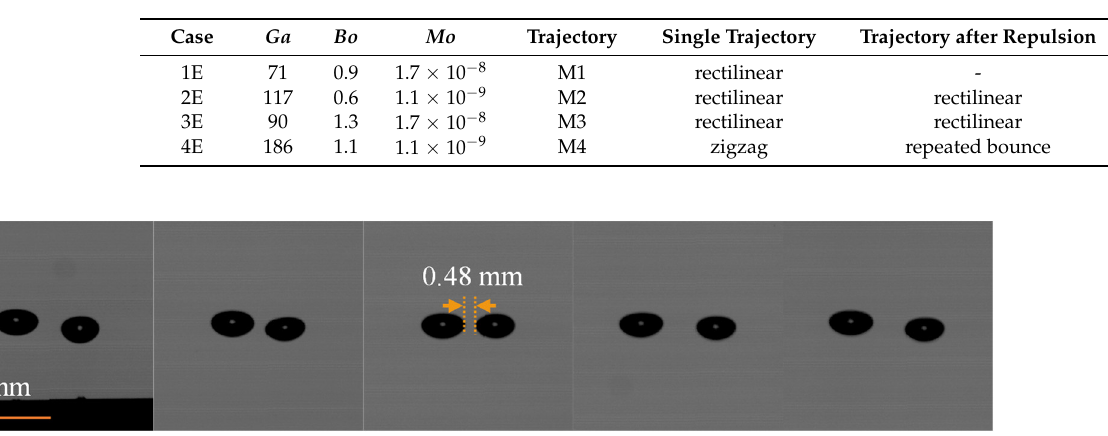
zigzag transition of a single bubble, and the dotted line is the critical curve for the standing eddy emerging via axisymmetric simulation. The open symbols indicate kissing, and solid symbols correspond to nonkissing. We found that the kissing transition is in the vicinity of the zigzag transition curve and the standing eddy curve. Interestingly, we observed nonkissing repulsion in the rectilinear region, not only in the zigzag region. It remains unknown whether the zigzag or standing eddy is the most important factor here, but it correlates with single bubble motion. The bubbles repeatedly bounced (M4) as they pro- gressed to the more unstable region. Figure 4. Phase diagram of a single bubble’s behavior (Cano–Lozano et al., 2016) and a pair of bub- bles’ behaviors in the ( Ga , Bo ) plane. Solid line: critical curve for zigzag transition of a single bubble. Do tt ed line: critical curve for the standing eddy emerging via axisymmetric simulation. ● : M1. ■ : M2. △ : M3. ♢ : M4. 3.2. Shape of a Pair of Bubbles with Nonkissing Repulsion We found that nonkissing repulsion of bubbles occurred in the vicinity of the zigzag transition curve and the standing eddy curve from the above results. Moreover, we ob- served the nonkissing repulsive behavior in the rectilinear region. Here, we consider the instability. One important factor in zigzag motion is the vorticity generated at the bubble surface. According to a discussion presented by Magnaudet and Mougin [13], who com- puted a fixed spheroidal bubble, the spanwise vorticity behind a bubble tends to become discontinuous in the streamwise direction with high Re , and the situation is unstable. As indicated by Cano–Lozano et al. [12], who computed paths of deformable bubbles, stream- wise vorticity induces zigzag motion because it is a double-threaded wake. The vorticity has to be asymmetric to move in a zigzag manner. Both vorticities are originally generated at the bubble surface and are proportional to velocity and curvature under free shear 0.5